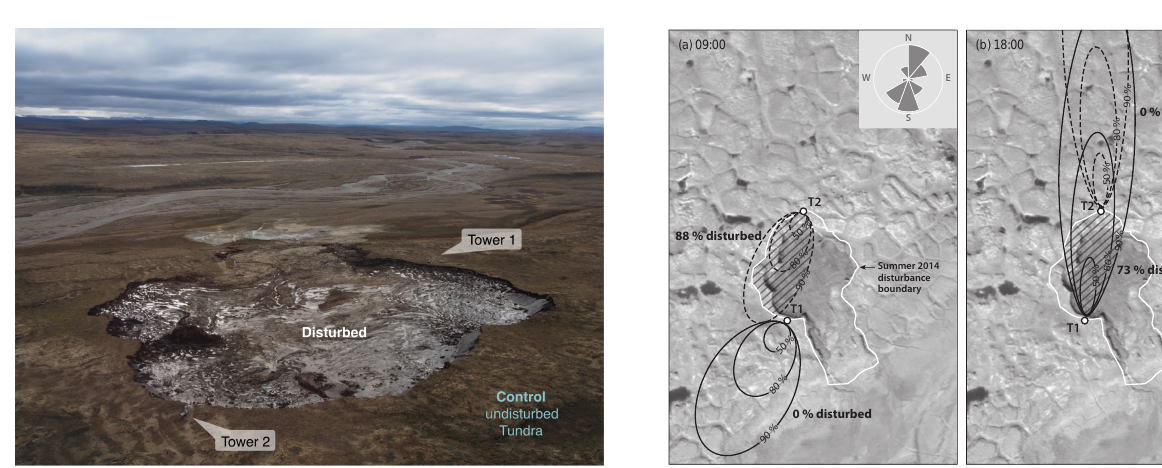
Figure 1. Aerial image of the dual eddy covariance system set-up with the location of both flux towers indicated. The valley trends NNE-SSW. View is to the south.